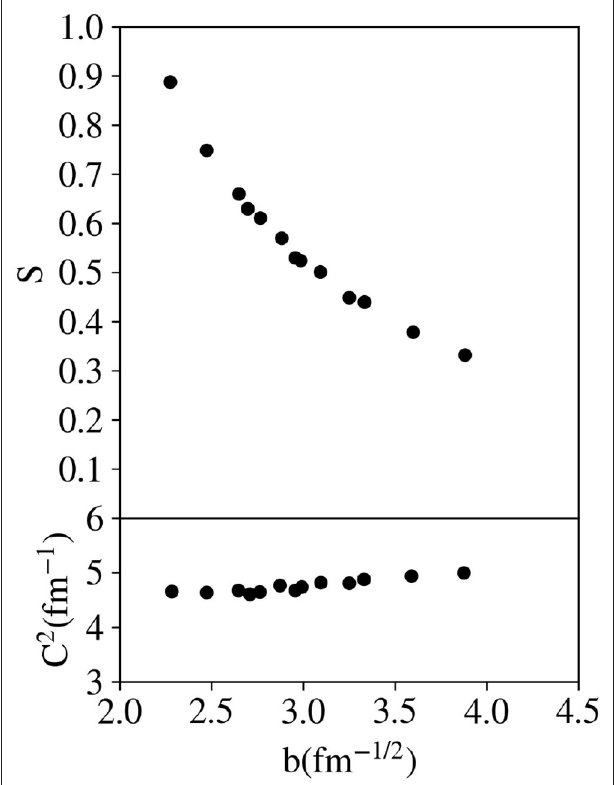
FIGURE 3 | The dependence of the spectroscopic factor (upper) and ANC ( C 2 ) (lower) on the geometry of the bound state potential of the state 9 Be(3 / 2 − ) + p ( j p = 3 / 2 − ) in 10 B( g . s .). The geometry is expressed by the different single particle ANCs (value b , see Equation 4), i.e., achieved by changing the parameters r 0 and a of the bound state potential in some